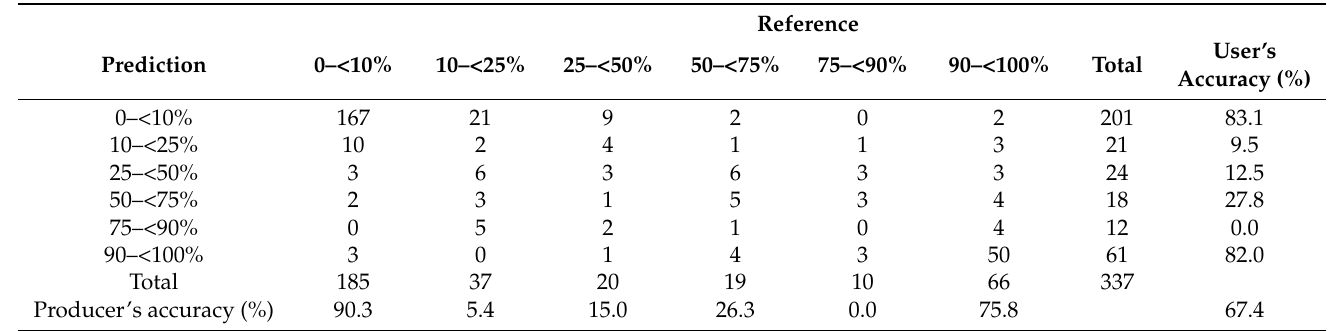
Table A12. Confusion matrix for current (Miller et al., 2009) model predicting IA BA change with Landsat RdNBR with offset.